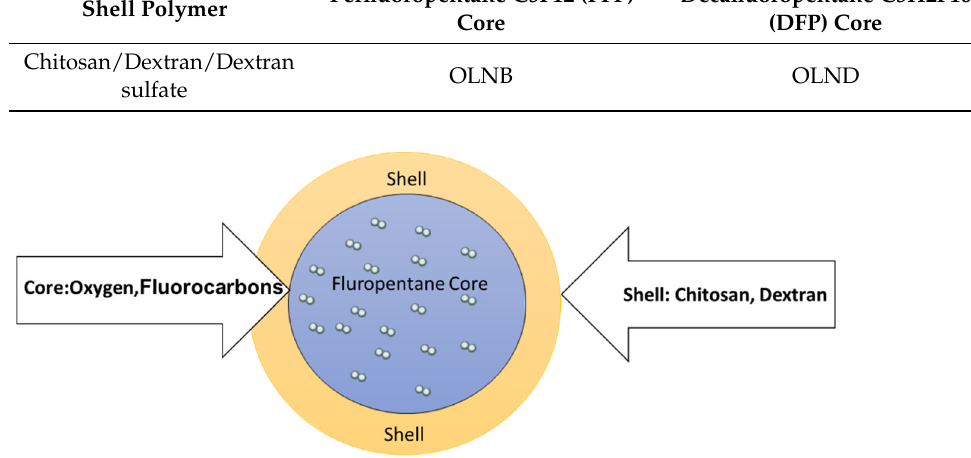
Figure 1. Structure of the oxygen-loaded